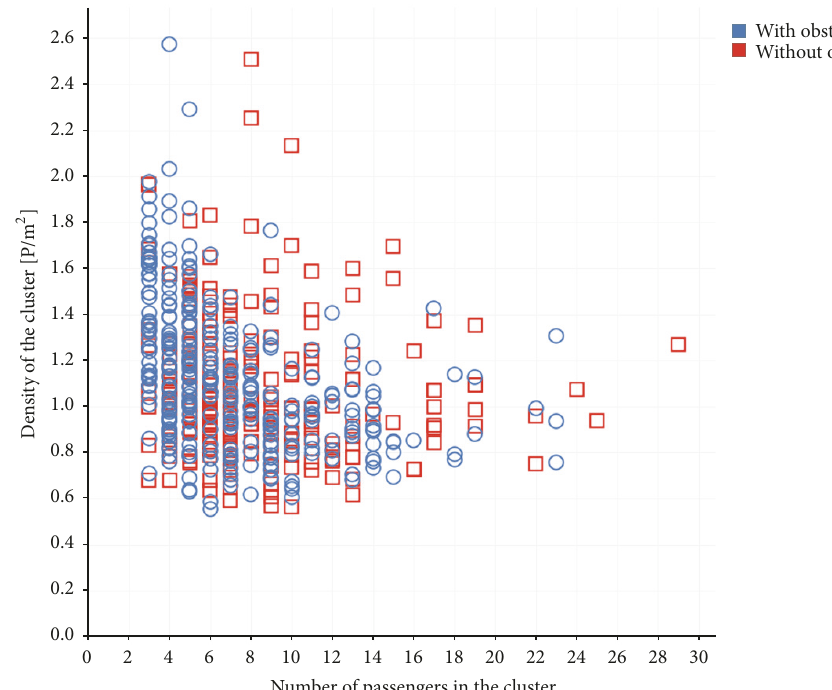
Figure 8: Correlation plot between passenger density (y-axis) and number of passengers in the cluster (x-axis) according to the presence of